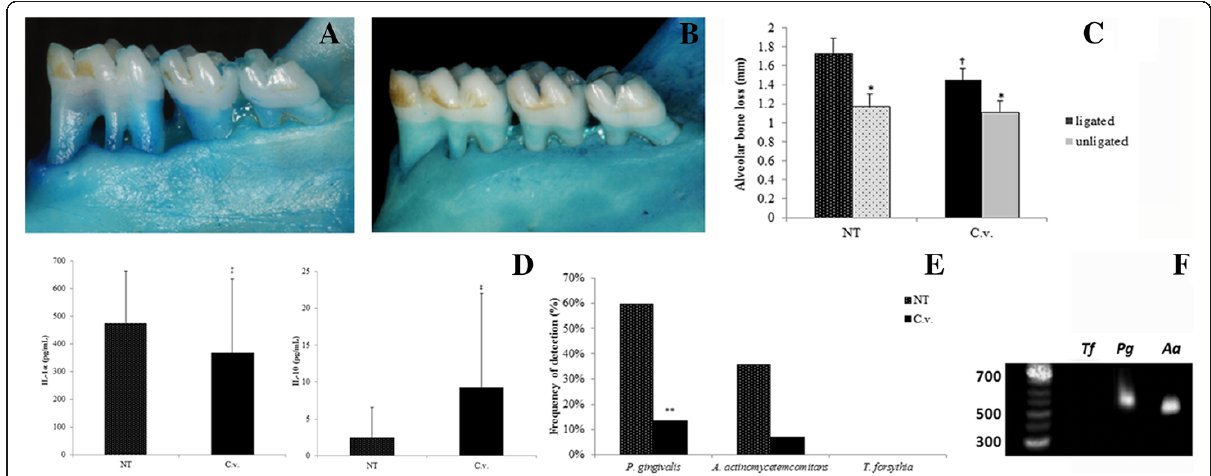
Figure 1 Panel illustrating data for morphometric, immune-inflammatory, and antibacterial assays. A and B ) Representative photographs illustrating the morphometric findings of C. verbenacea essential oil group ( A ) and non-treatment group (B). C ) Means and standard error of the mean (SEM) of alveolar bone loss (mm) for ligated and unligated teeth in both groups. Significant difference when compared to ligated teeth (*). Significant difference when compared to NT group ( † ) (student t test, p < 0.05). D ) Means and SEM of IL-1 α and IL-10 concentration (pg/ml) assayed by ELISA. Significant difference when compared to NT group ( ‡ ) by student t test, p < 0.05. E ) Frequency (%) of detection of periodontal pathogens in both groups. Significant difference when compared to NT group (**) by Fisher ’ s exact test, p < 0.05. F ) Representative reverse transcription – polymerase chain reaction products illustrating periodontal pathogens observed in one animal of the C. verbenacea essential oil